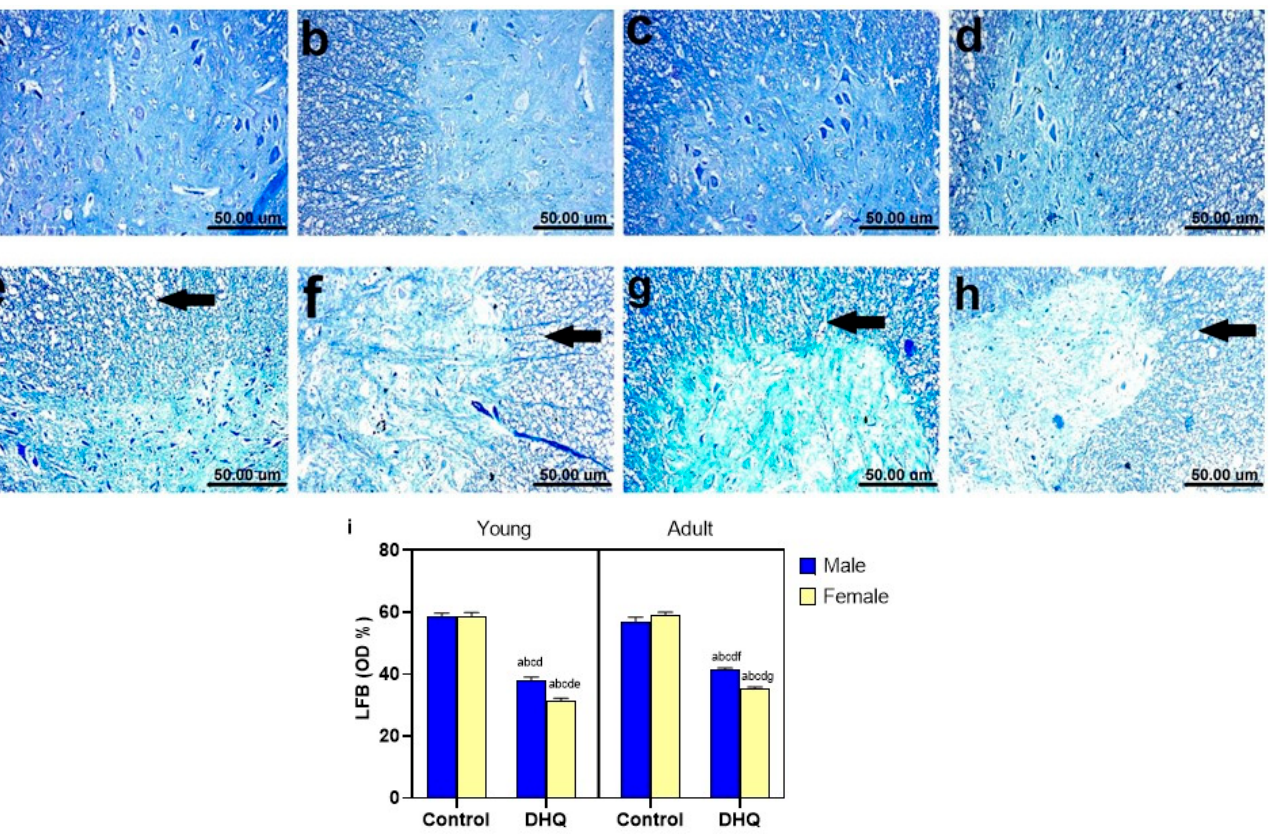
Figure 10. Histological Luxol fast blue-stained sections from spinal cords of ( a – d ) control rats, ( a ) young male, ( b ) young female, ( c ) adult male, and ( d ) adult female, showing apparently normal dark blue myelinated axons. ( e – h ) showing demyelination in white and gray matter (black arrow), ( e ) DHQ young male, ( f ) DHQ young female, ( g ) DHQ adult male, and ( h ) DHQ adult female. (Scale bar 50 um). ( i ) Quantitative analysis of LFB staining in sections from spinal cords. Each bar with a vertical line represents the mean ± S.D. of 5 rats per group (5 fields/rat). a vs. control young male, b vs. control young female, c vs. control adult male, d vs. control adult female, e vs. DHQ young male, f vs. DHQ young female, and g vs. DHQ adult male using three-way ANOVA followed by Tukey’s post hoc test; p < 0.05. DHQ; diiodohydroxyquinoline.